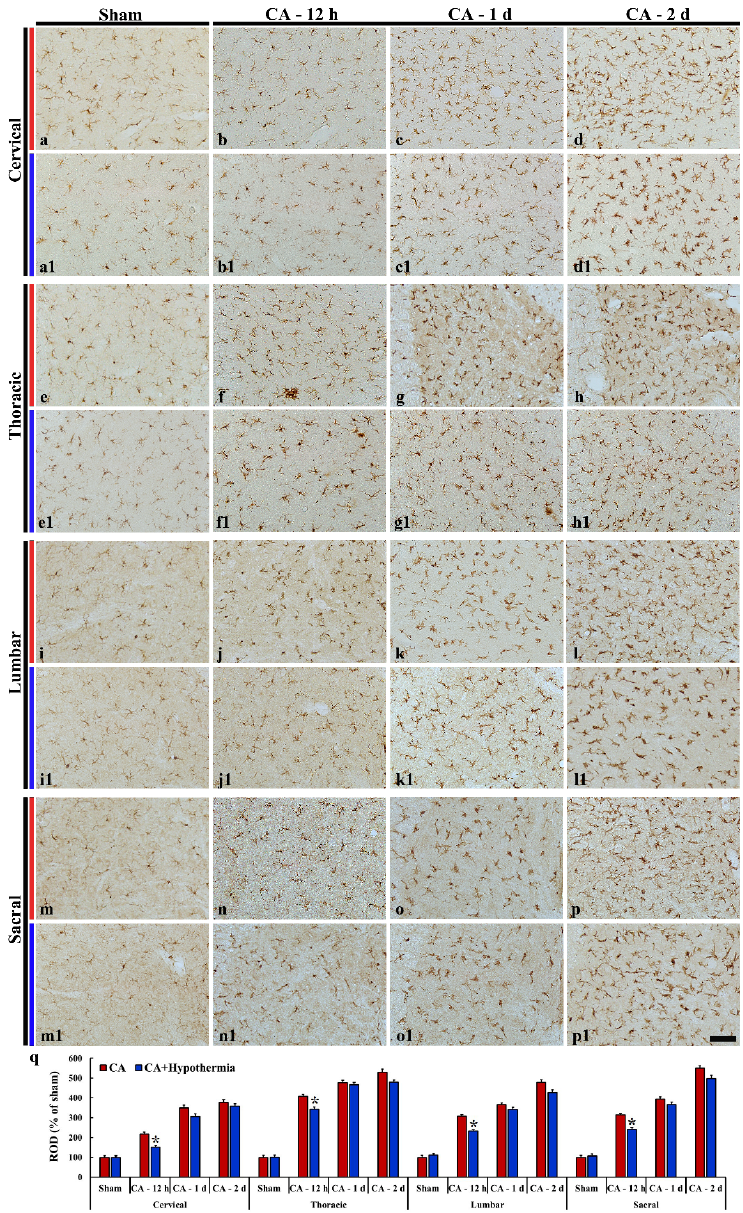
Figure 6. Iba-1 immunohistochemical staining in the spinal cord of the sham operated ( a,a1,e,e1,i,i1,m,m1 ), CA operated ( b – d , f – h , j – l , n – p ), and CA/hypothermia operated ( b1 – d1 , f1 – h1 , j1 – l1 , n1 – p1 ) groups. After CA, Iba-1 immunoreactivity is increased with time. Hypothermia significantly decreases microgliosis in all spinal levels only at 12 h after CA. Scale bars = 50 μ m. ( q ) Quantitative analysis of Iba-1 immunoreactivity in the spinal cord in the CA and CA/hypothermia groups ( n = 9 per group, * p < 0.05, vs. each CA group). The bars indicate the means ± SEM.